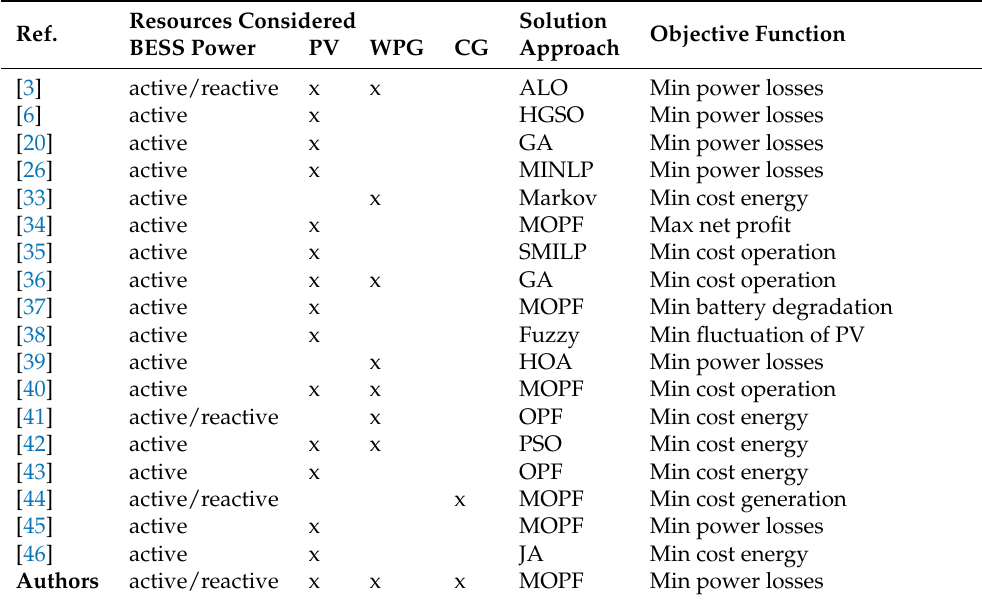
Table 1. Integration of BESS with RES.